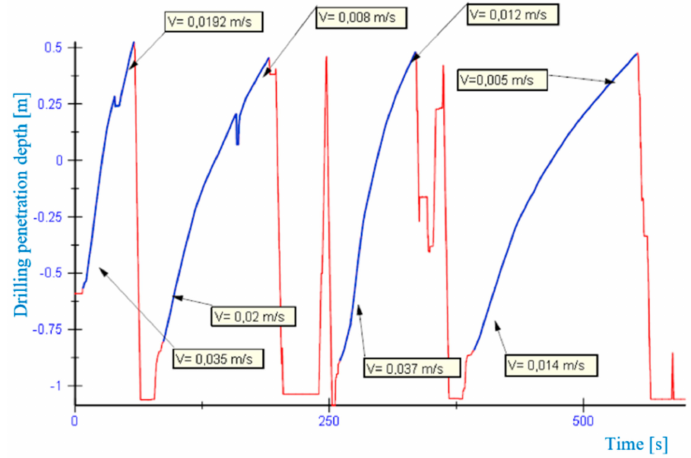
Figure 12. The course of the drilling process on the first test stand in borehole No. 1.